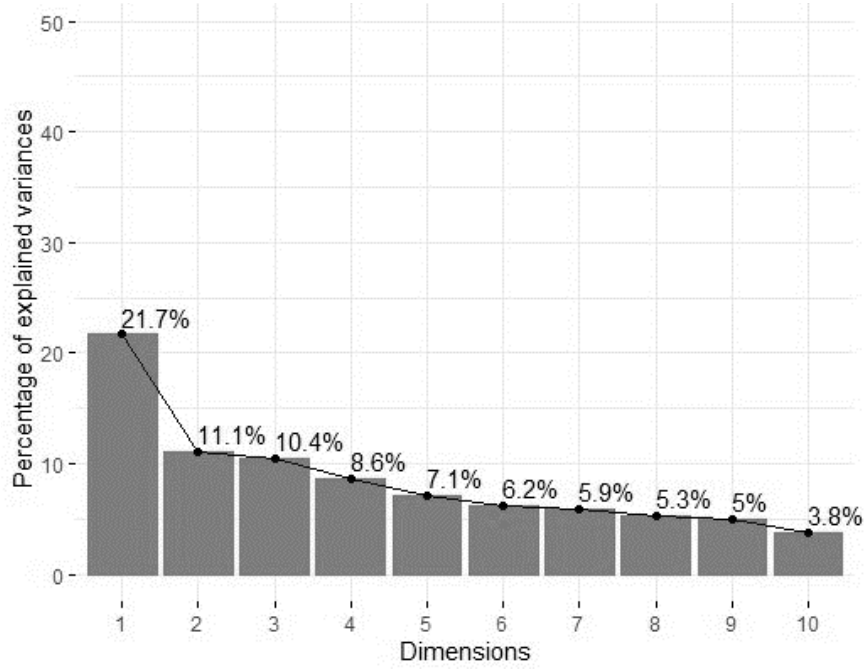
Figure 6. Scree plot with percentage of explained variances per principal component factors (dimen- sions) of cluster 2.